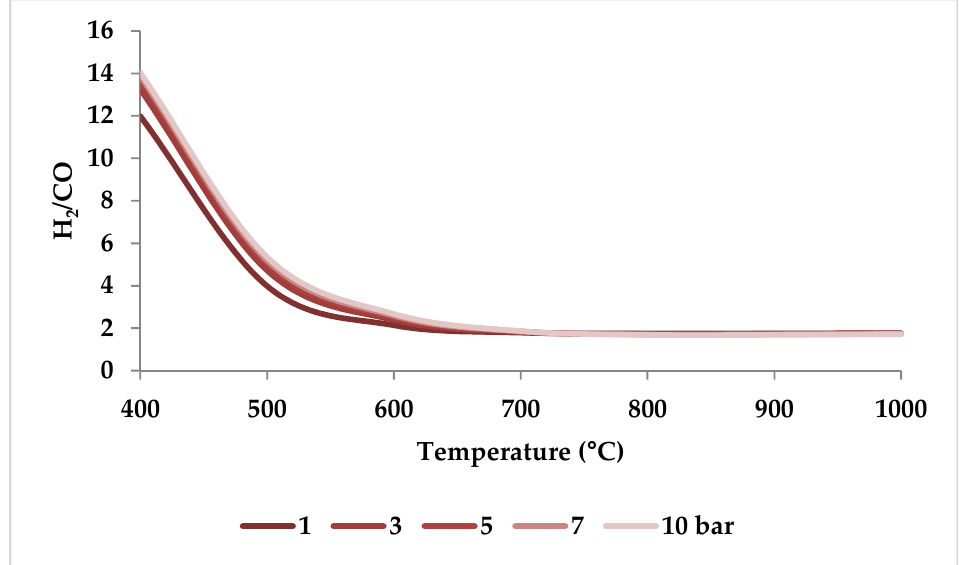
Figure 11. Thermodynamic equilibrium H 2 /CO ratios under different pressures (bar) versus temperature, molar ratio: CH 4 :CO 2 :H 2 O:O 2 = 1:0.3:0.3:0.2.